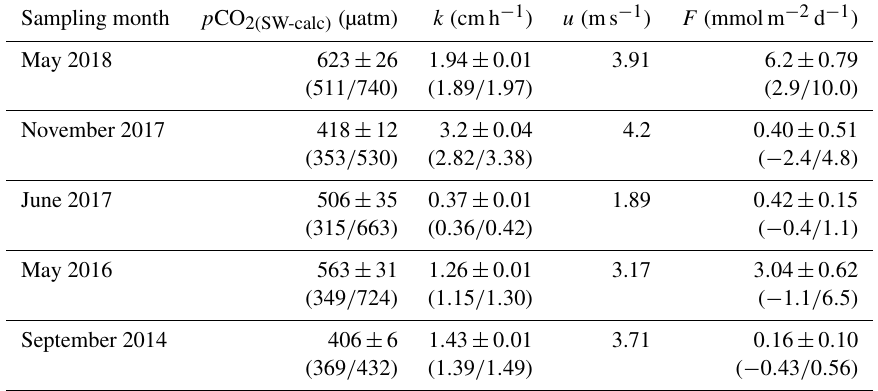
Table 2. Mean standard error of the mean and range of p CO 2 ( SW ) , k , u and F in the Saguenay Fjord surface waters. Numbers in parentheses indicate the observed or calculated ranges. Overall, the total area-averaged degassing flux of the fjord adds up to 2 . 14 ± 0 . 43mmolm − 2 d − 1 or 0 . 78 ± 0 . 16molm − 2 yr − 1